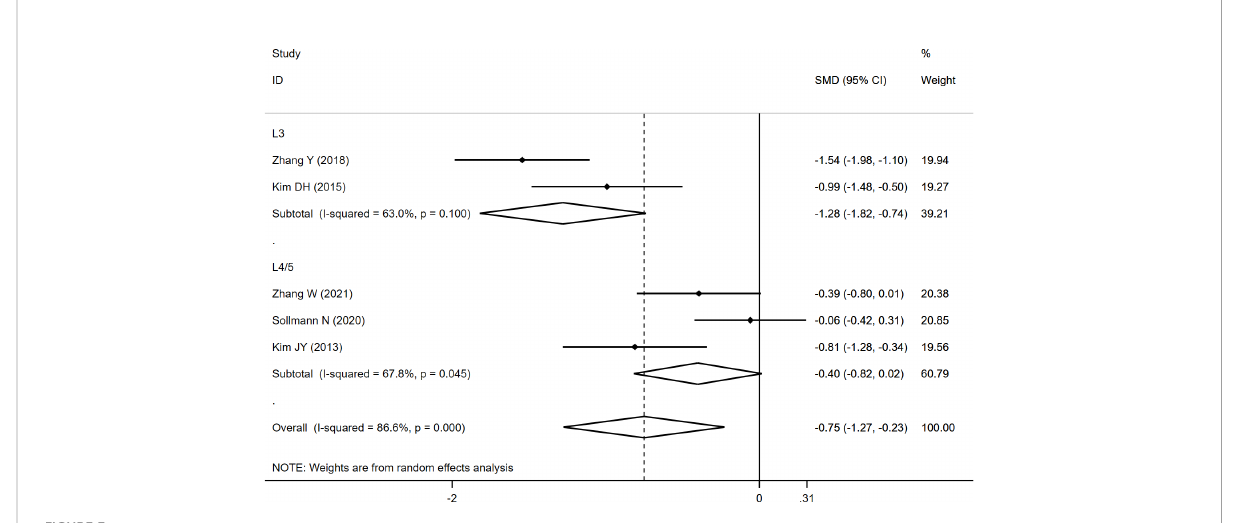
FIGURE 3 Forest plot of the CSA PS comparing the fracture group with the non-fracture group.